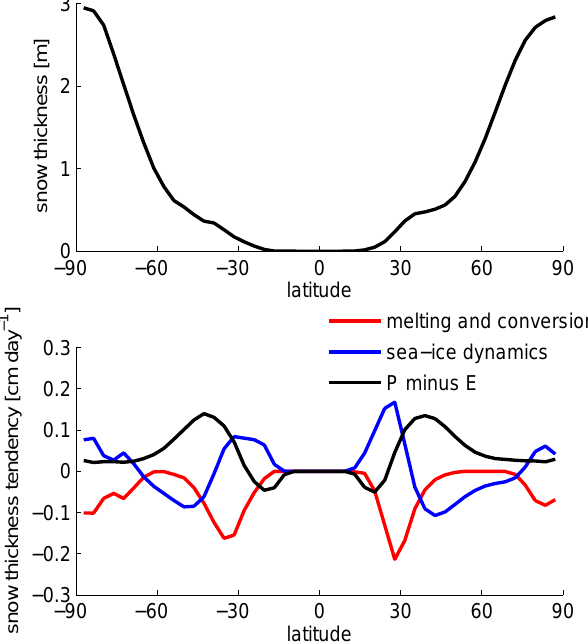
Fig. 5. Simulation with low bare sea-ice albedo and 209 ppm CO 2 , which results in 70 % sea-ice cover. Top: zonal-mean annual-mean thickness of snow on sea ice. Bottom: zonal-mean annual-mean thickness tendencies for snow on sea ice: local melting and snow/sea-ice conversion (red), sea-ice dynamics (blue), and snowfall minus evaporation over sea ice (black).